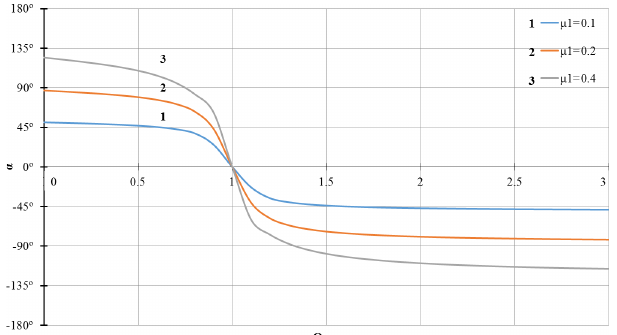
Figure 11. Dependence of the moment of force transmissibility of the system γ on the rotor velocity (cid:127) with nonlinear stiffness coef- ficient of the support K 3 = 0 . 05 at value of the coefficient of linear viscous damping µ 1 = 0 . 1 and various values of nonlinear viscous damping coefficient µ 3 .